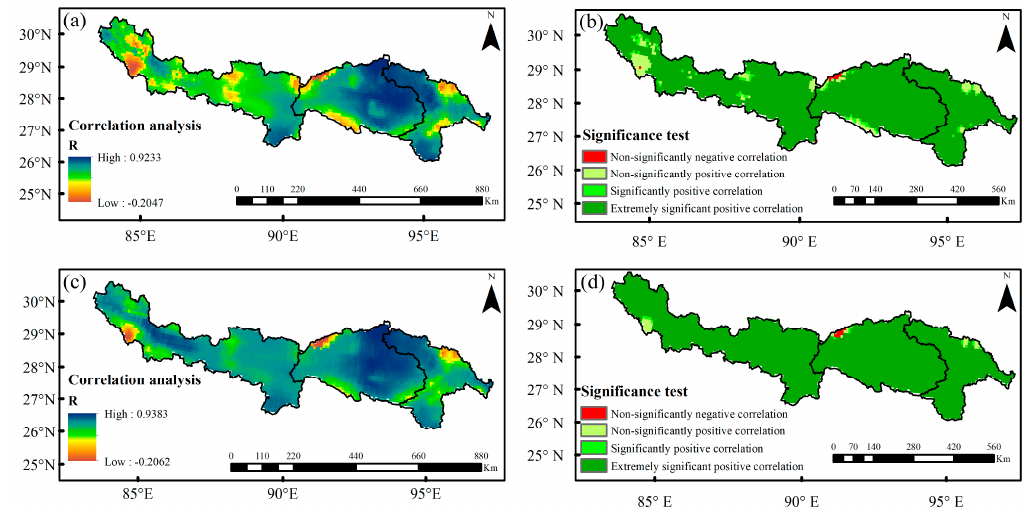
Figure 15. Annual ( a, b ) and growing season ( c, d ) correlation analysis between the SPEI and soil water content with the significance